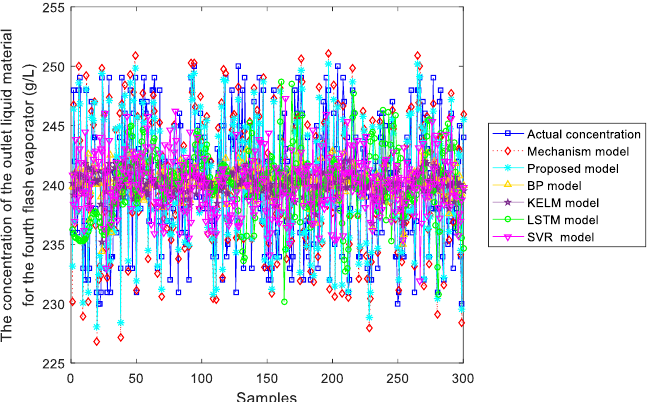
Figure 5. Comparison of actual concentration and predicted concentration for different models when the data fluctuate greatly.